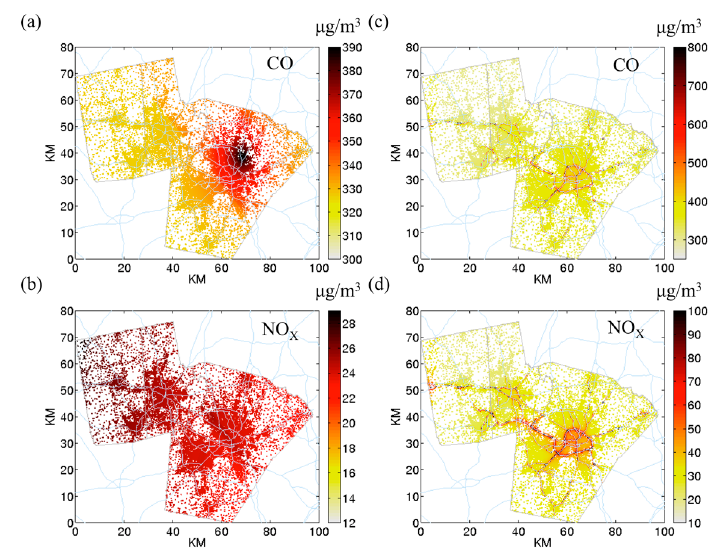
Figure 1. Outdoor concentration of CO and NO x at Census block centroids at 07:00. ( a ) CO outdoor space-time ordinary kriging (STOK); ( b ) NO x outdoor STOK; ( c ) CO outdoor